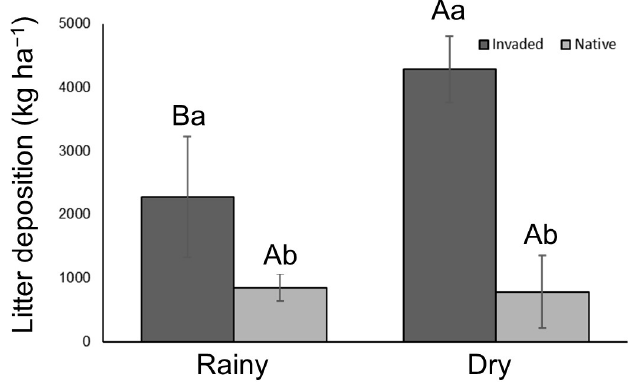
Figure 2. Litter deposition (kg ha − 1 , mean ± SD) in both invaded and non-invaded environments during the rainy and dry season in a tropical Cambisol, Caatinga ecoregion, Paraiba, Northeastern Brazil. Within the invaded and non-invaded environments, the same capital letters represent no significant differences, whereas within the rainy and dry season, the same small letters represent no significant differences by Bonferroni’s test ( p <